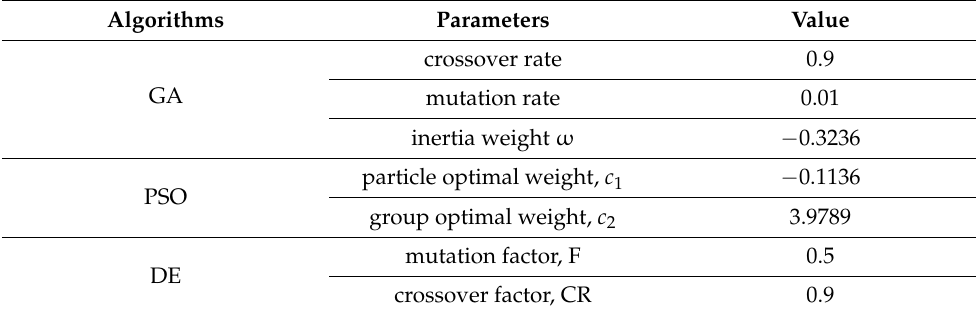
Table 1. Control parameters of related algorithms.